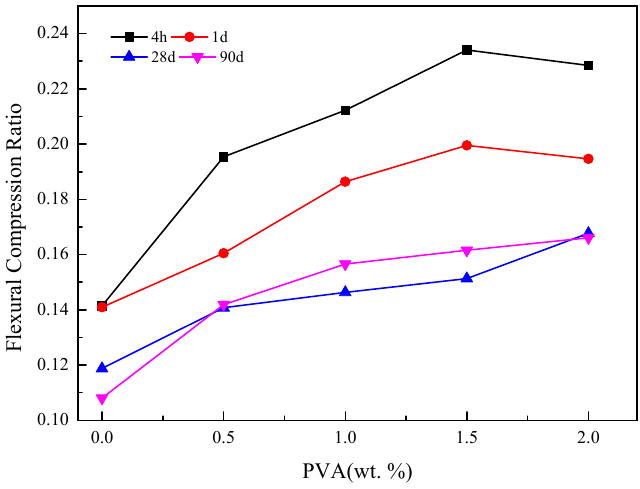
Figure 3. The flexural compression ratio of mortar.